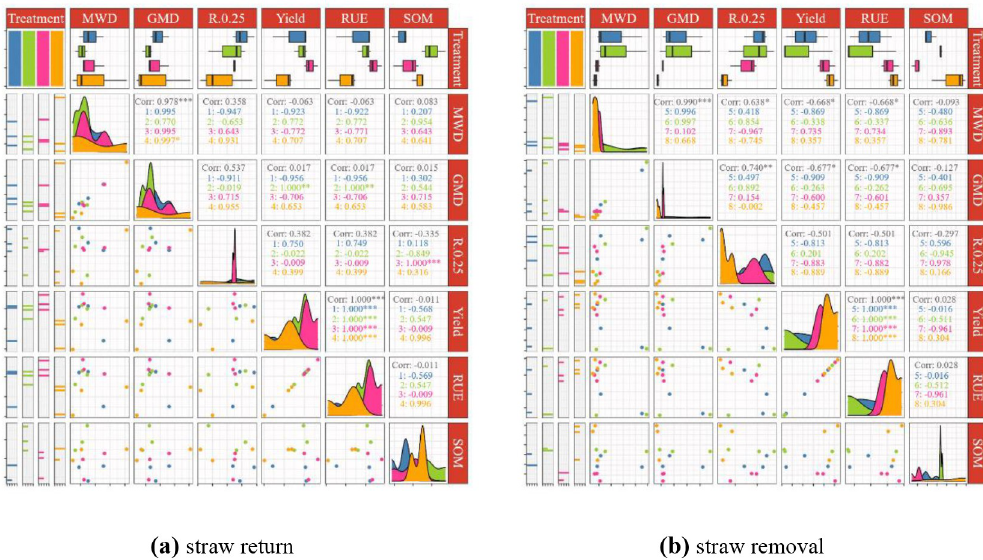
Fig 9. Pearson’s correlation analysis. Note: � P < 0.05; �� P < 0.01; ��� P < 0.001; (1) means NTS; (2) means SUS; (3) means RTS; (4) means CTS; (5) means NT; (6) means SU; (7) means RT; (8) means CT.MWD, mean weight diameter. GMD, geometric mean diameter. R 0.25 , > 0.25 mm aggregates content. RUE, rainfall utilization efficiency. SOM, soil organic matter. The first column rectangle and its different fillings in the middle indicate different tillage measures and the corresponding eighth column indicator repetition times. Boxplot of second behavior corresponding to tillage and indicator. The lower left is the scatter plot of the corresponding indicator, and the upper right is the correlation coefficient of the two indicators.